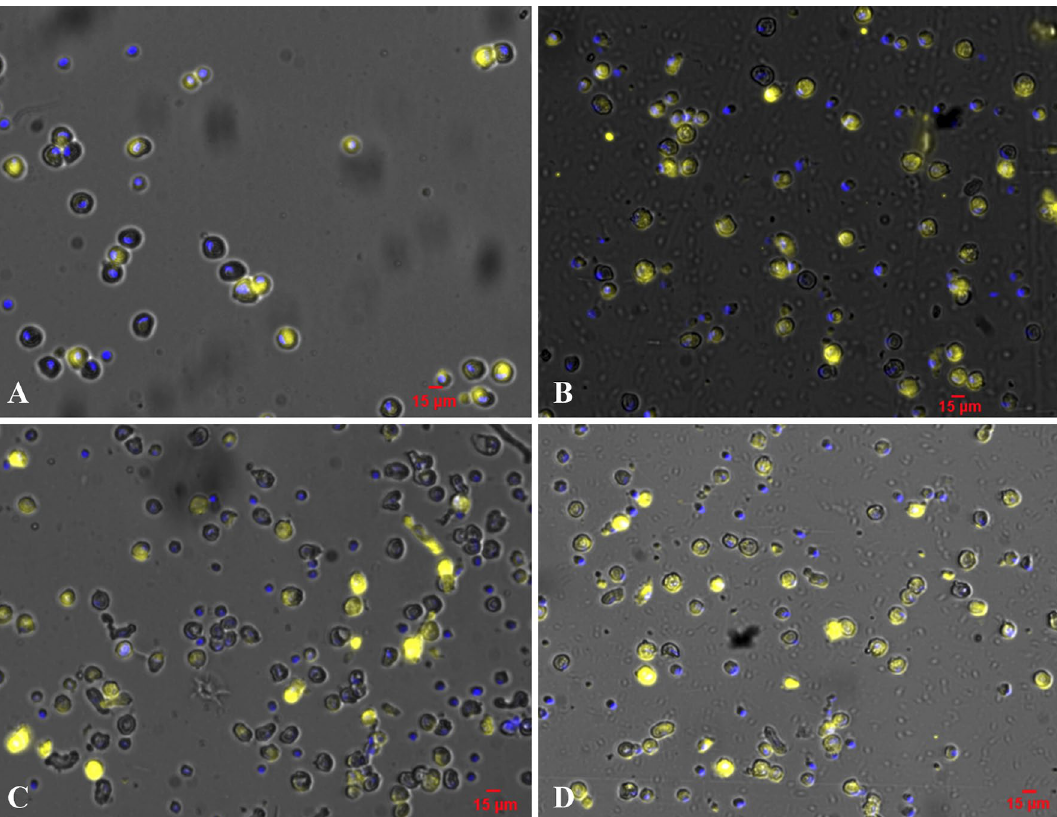
Figure 5. Example of single cell positive expression. Nuclear staining is shown in blue and NKA-α and SLC26a6 staining is shown in yellow. ( A ) The expression of NKA-α at 16:00. ( B ) The expression of NKA-α at 22:00. ( C ) The expression of SLC26A6 at 16:00. ( D ) The expression of SLC26A6 at of naked carp at night were significantly higher than that observed during the day, while the feed intake was significantly lower at night than during the day. Transporters involved in the regulation of intestinal epithelial ions mainly include NKA, Cl − /HCO 3 − exchang- ers, Na + -HCO 3 − co-transporter and others. When teleost fish are transferred to seawater, osmoregulation is maintained by increasing the expression of NKA mRNA and its activity in intestinal epithelial cells 31,32 . The SLC4 and SLC26 gene families are the main proteins involved in HCO 3 − transport in organisms, and play an important role in maintaining the pH and ion balance of body fluids 33,34 . When naked carp were transferred directly from fresh water to saline-alkaline water, the expression of NKA increased in the basolateral membrane of the intestine likely as a response to increase salt uptake and maintain the osmotic pressure gradient for water absorption. Yao et al. 3 found that the naked carp transferred from river water to lake water resulted in a respiratory alkalosis and ion rise in the blood. The expression of SLC26A6 and SLC4A4, on the other hand, likely increased as a compen- satory measure to aid in the secretion and excretion of accumulated bicarbonate concentrations 6 . Perhaps most notably, the drinking rate of naked carp was significantly higher at night than that during the day which aligned with the heightened expression of NKA-α, SLC26A6 and SLC4A4, further supporting that osmoregulation and acid–base balance appear to be partitioned to a greater extent during this period of the daily cycle. Fish usually exhibit certain feeding rhythms that can be connected with external environment and internal factors. Generally, feeding rhythms represent the evolutionary trade-off between food availability, metabolic demand and predator risk 35 . During the experiment, the mode of self-feeding was closer to the survival condi- tions of natural environment than the mode of artificial feeding by schedules. The use of self-feeders can not only promote growth, improve feed conversion and reduce feed waste, but also find some behavioral character- istics related to self-feeding activities 36 . The study found that self-feeding intake of naked carp was higher in the daytime, indicating increased feeding behavior during the day. Naked carp triggered the self-feeder when they need to ingest feed. The daily feed intakes of L15 and FW in daytime was 3.50 g kg −1 and 10.17 g kg −1 , respec- tively, significantly higher than that of 1.79 g kg −1 and 5.55 g kg −1 at night. This indicated that high feed intake in daytime could depend on surrounding lights, since visual feeder usually feed during the day 13 . In addition, the intestinal tract of fish can improve digestive physiological activities through rhythmic digestive enzyme activi- ties, and then affect feeding activities 37 . Daily rhythms have evolved from long-term adaptation of life to daily changes of environmental factors on the Earth 9,38 . Studies represented by zebrafish have shown that fish exhibit distinct daily rhythms in physiology and behavior 21 , which include feeding rhythms.